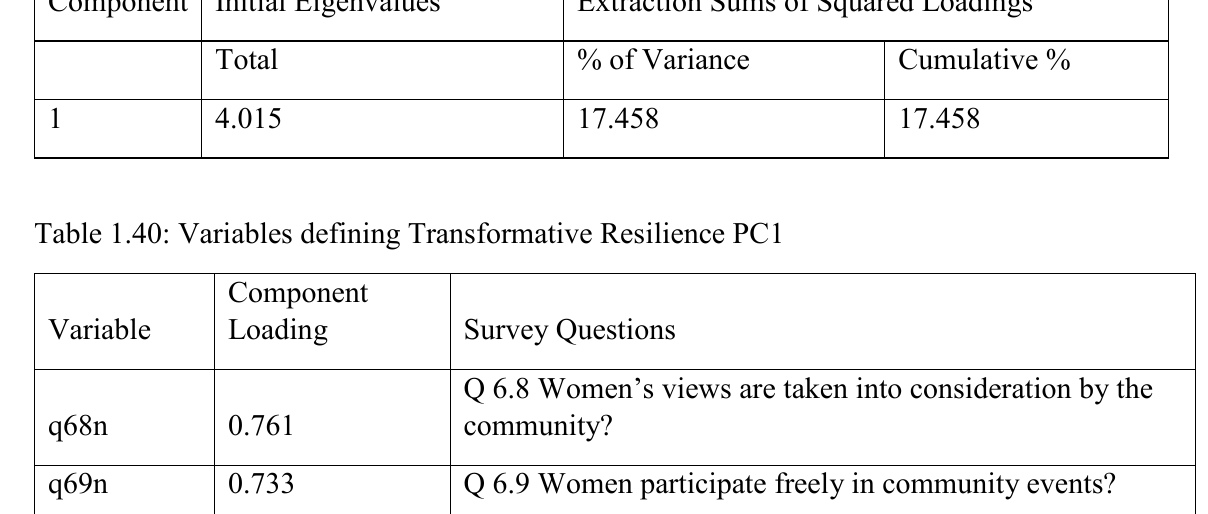
Table 1.39: Variance explained for Transformative Resilience PC1 Component